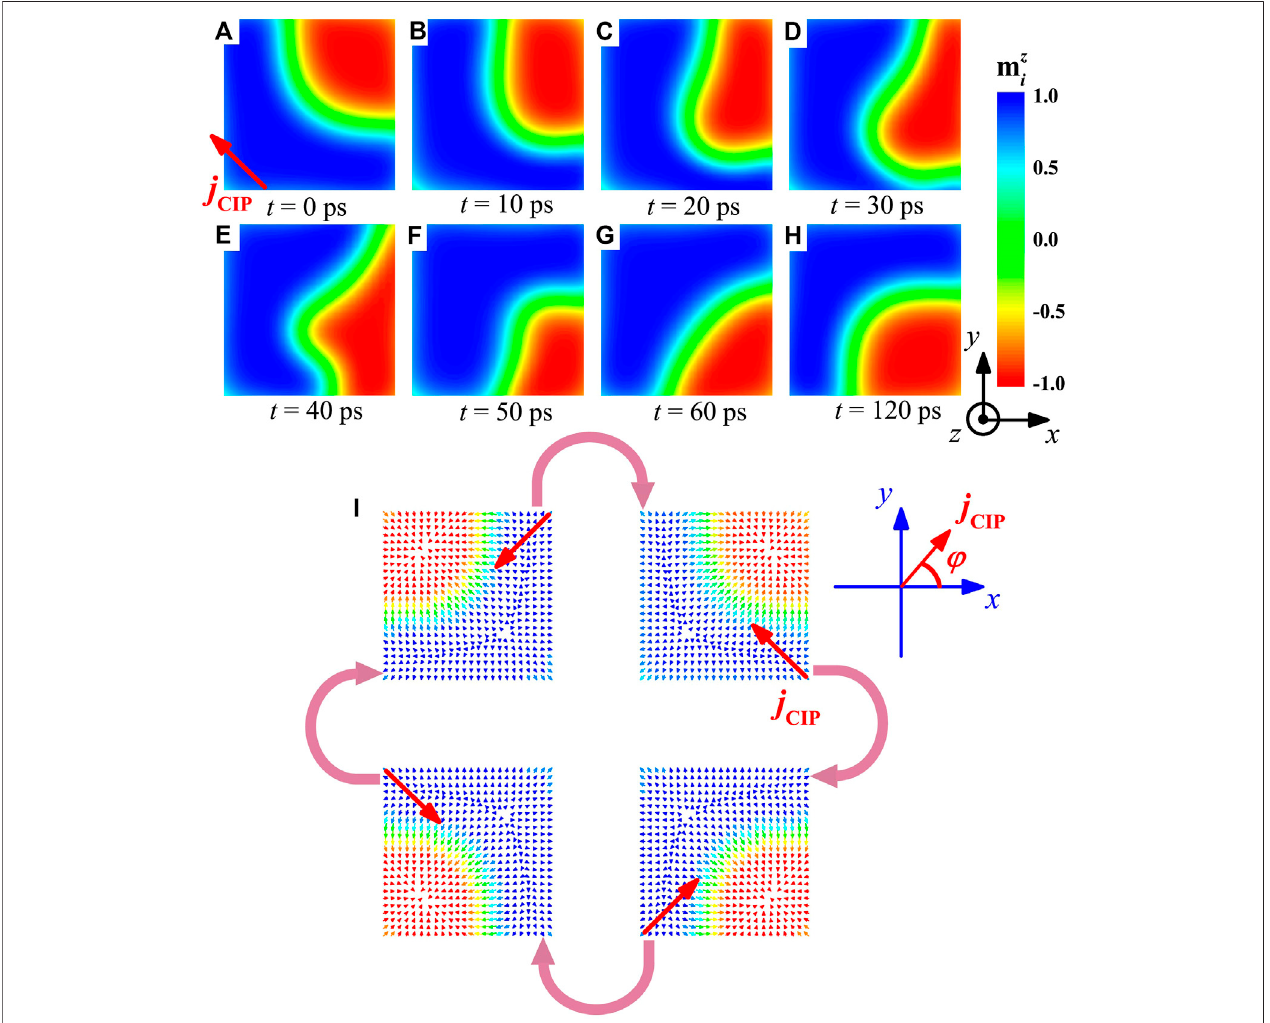
FIGURE 4 | (A) – (H) The gradual shift of kink from UR to LR corner, driven by in-plane current pulse with current density J CIP (cid:2) 1.4 × 10 12 Am − 2 , current duration t dur (cid:2) 50ps, and injection angle φ (cid:2) 135 ° . (I) Schematic illustrations of switching sequences for the kinks driven by in-plane current pulse. Here we used the straight red arrows to mark the injection direction of current J CIP , and the curved pink arrows to denote the switching sequences of magnetic